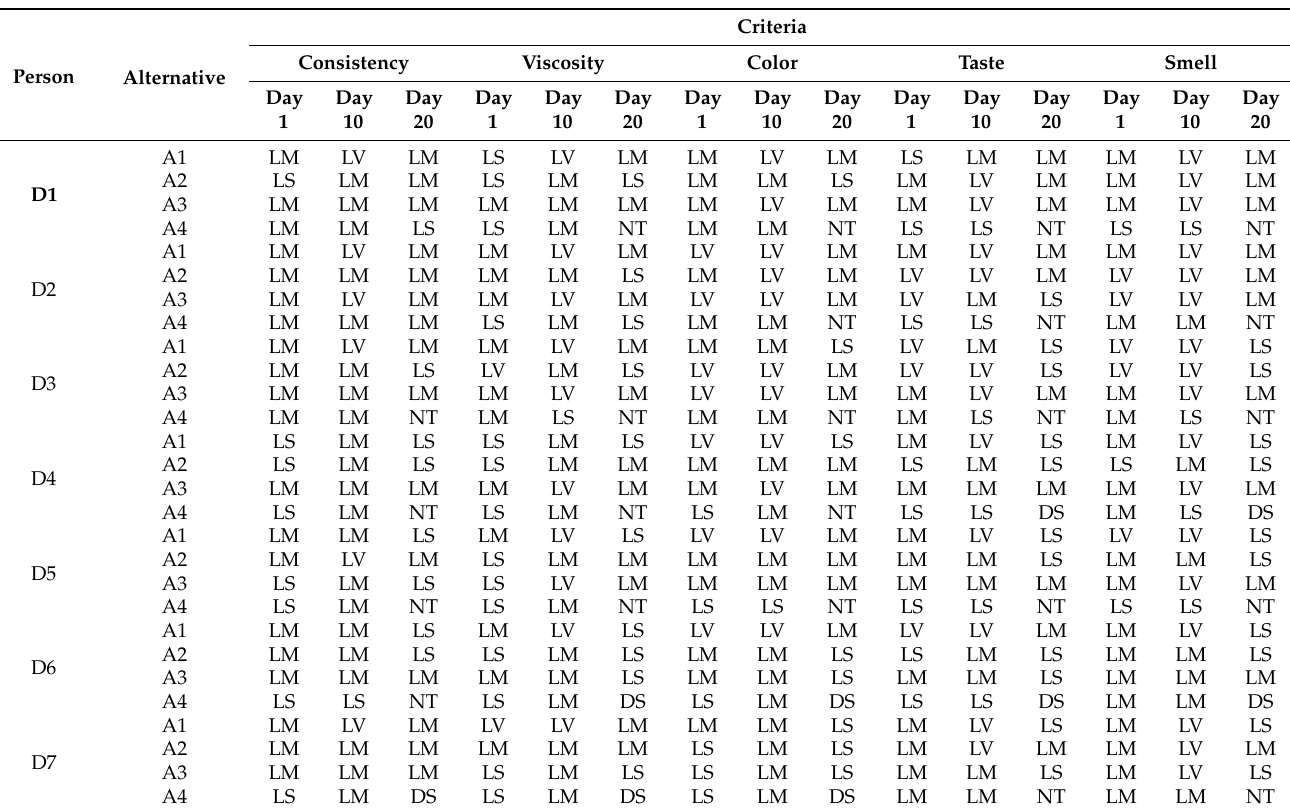
Table 4. Criteria of assessment by each person of all